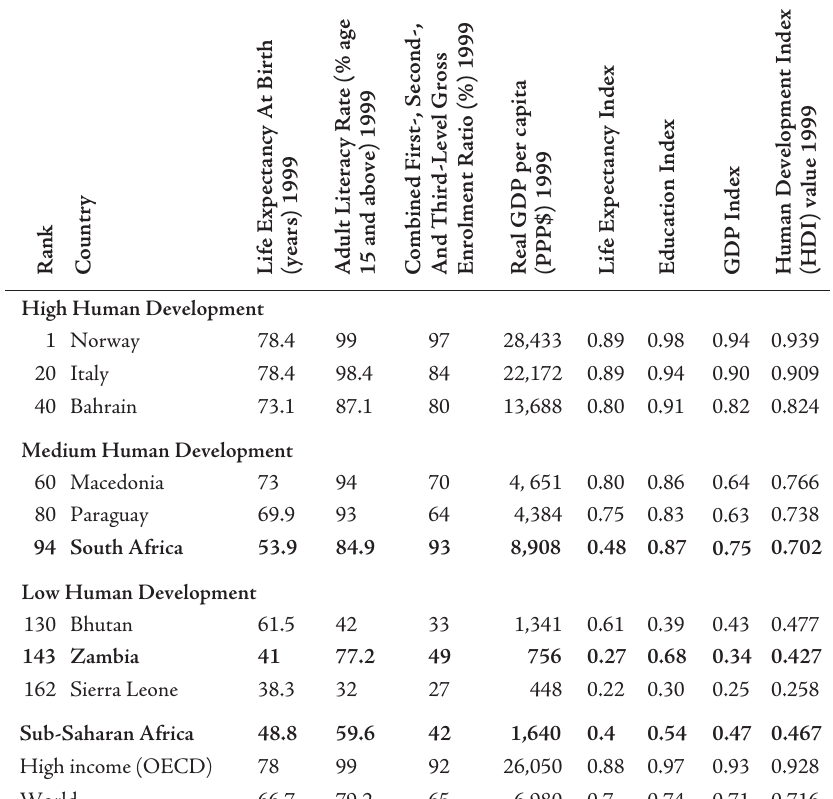
Table 7 – Human Development Index,